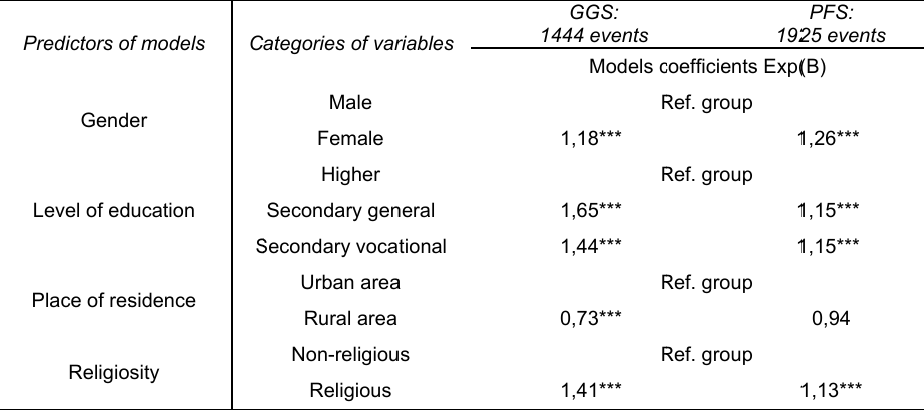
Table 4. Co after the ag Predictors